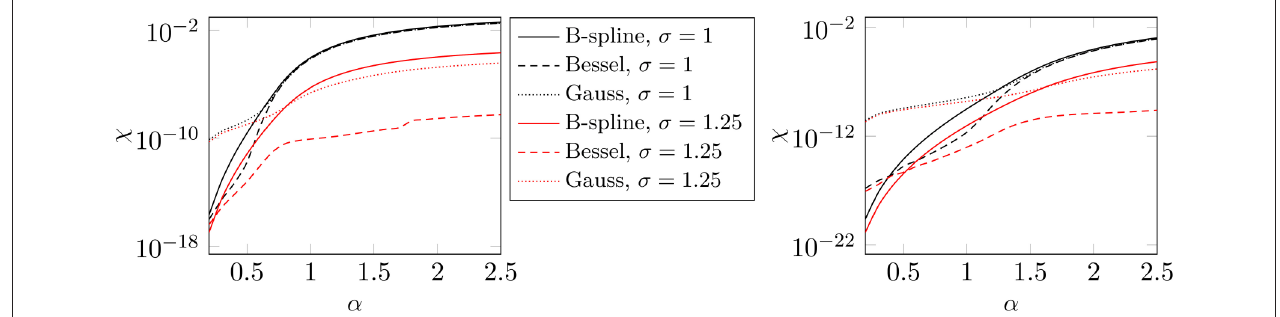
FIGURE 7 | Predicted errors χ std as presented in Examples 4.6, 4.8, and 4.9 for the support parameter m respectively.